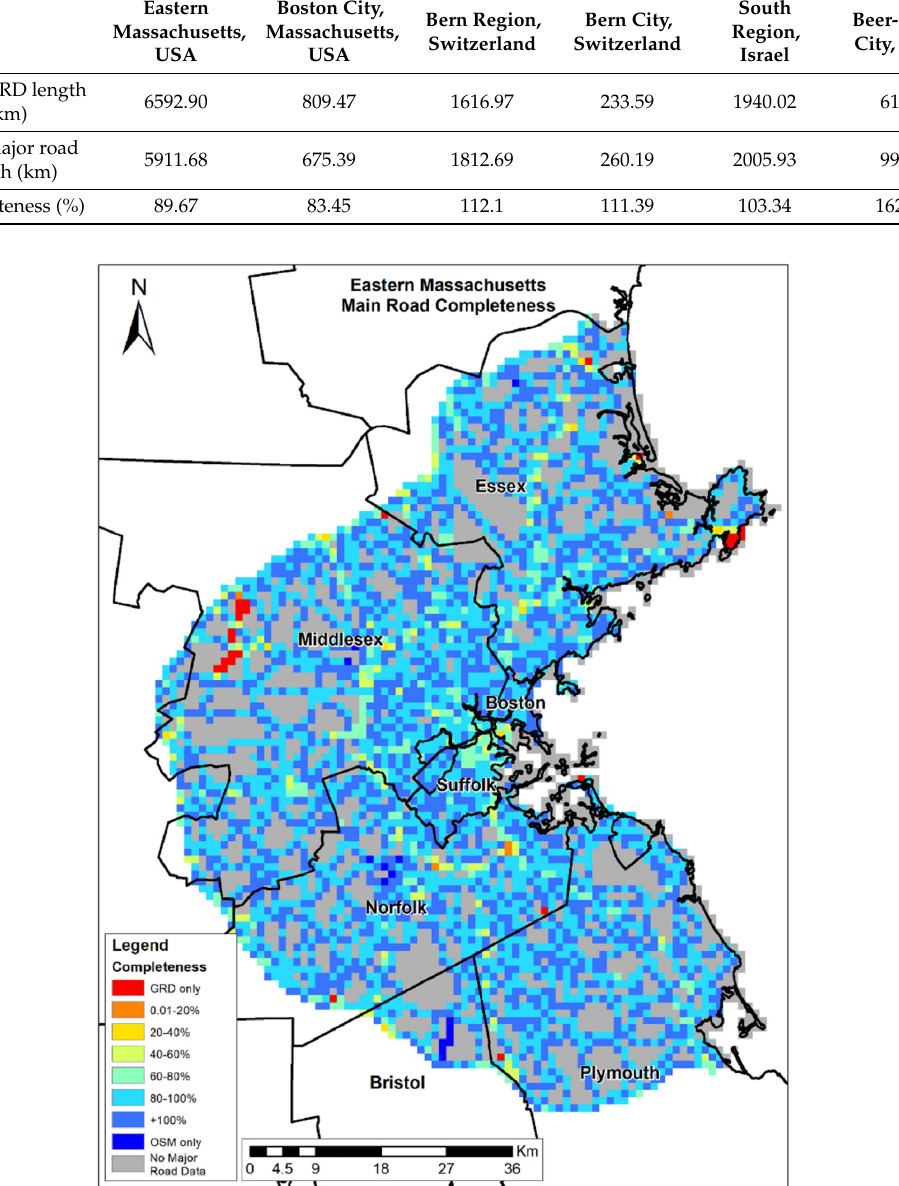
Figure 2. Eastern Massachusetts’ completeness